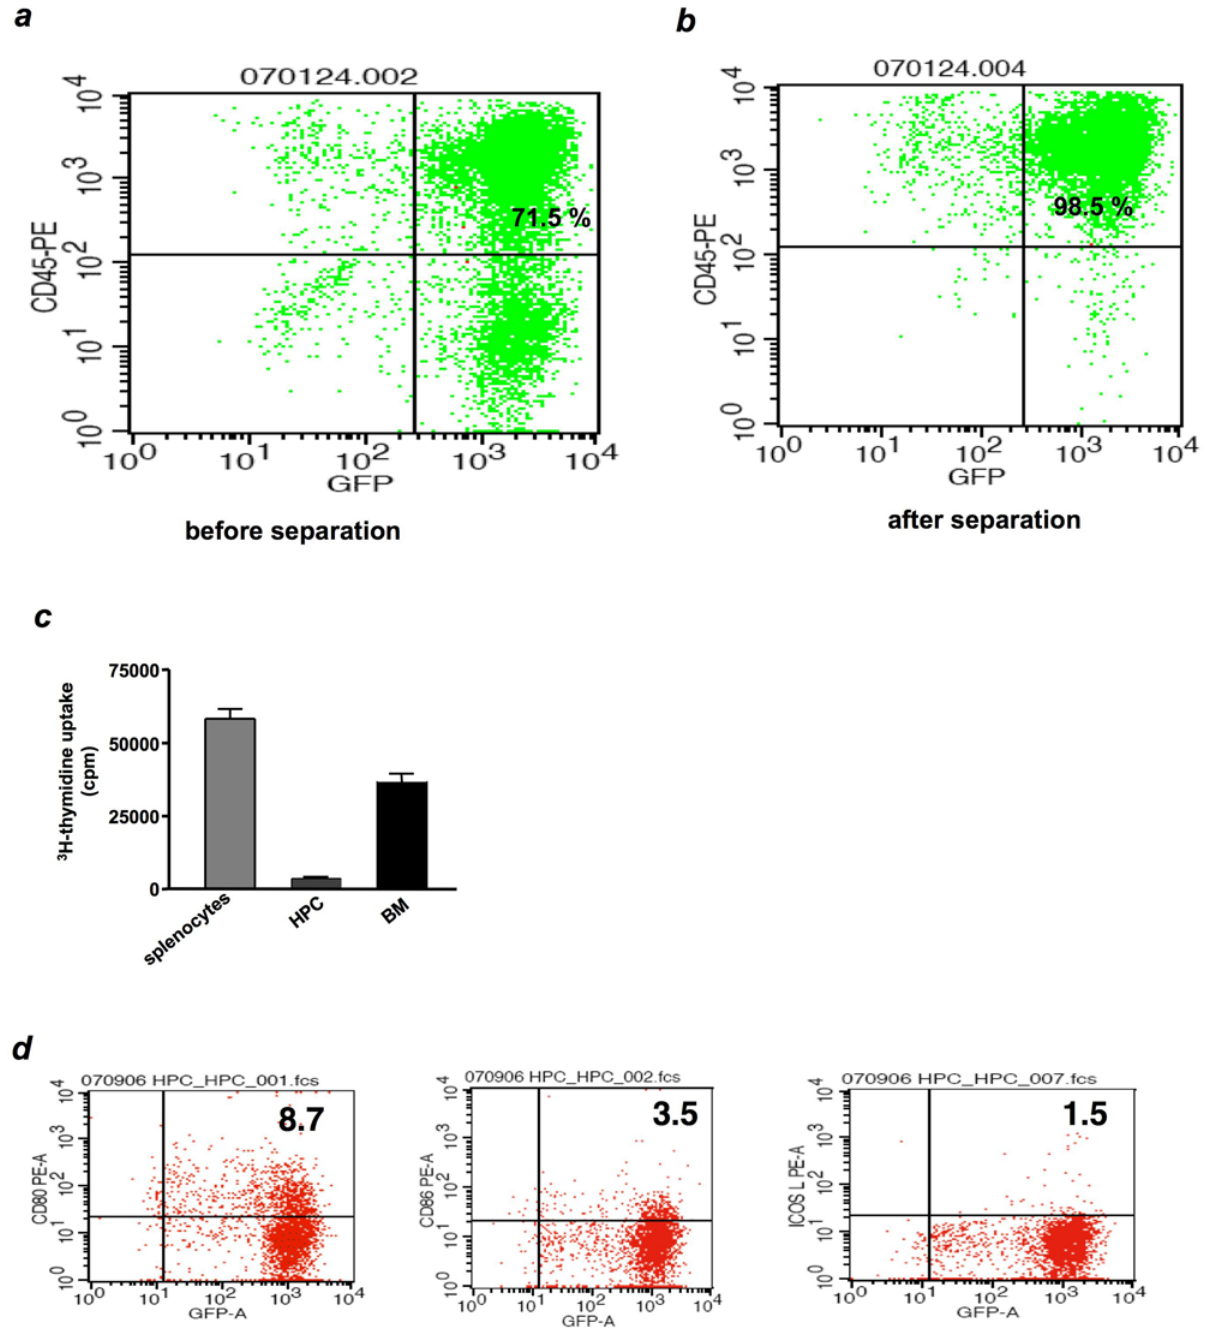
Figure 1. HOXB4-transduced ES cells robustly differentiate into CD45 + . HOXB4-transduced ES cells were allowed to form embryoid bodies. The cell clusters were dismantled and subsequently treated with a hematopoietic differentiation medium. The GFP expressing cells were . 70% CD45 by day 26 (A) . These cells were sorted by immunomagnetic bead separation to . 98% purity (B) . To determine whether HPCs stimulate allogenic T cells, MRL splenocytes were co-cultured with irradiated 129SvJ splenocytes, HPCs, or bone marrow cells. Cell proliferation was determined by 3 H- thymidine uptake. Splenocytes and bone marrow cells, but not HPCs, robustly stimulated allogenic T cells to proliferate (C) . Lastly, immunophenotyping of the HPCs revealed poor expression of co-stimulatory molecules CD80, CD86, and ICOSL (D) . with mixed chimerism greater than 10% were transplanted donor HPCs induce donor-specific cardiac graft tolerance type 129SvJ cardiac allografts. All chimeric animals accepted their We therefore asked whether the chimeric MRL mice were allografts (n= 12) showing that established mixed chimerism was tolerant to the donor 129SvJ cardiac allografts. To do this, MRL protective (Figure 4). As expected, syngeneic allografts were mice were sublethally irradiated and transplanted 2 6 10 6 HPCs. Mixed chimerism was first monitored after 14 days, and animals tolerated but Balb/c third party allografts were not. Balb/c third-